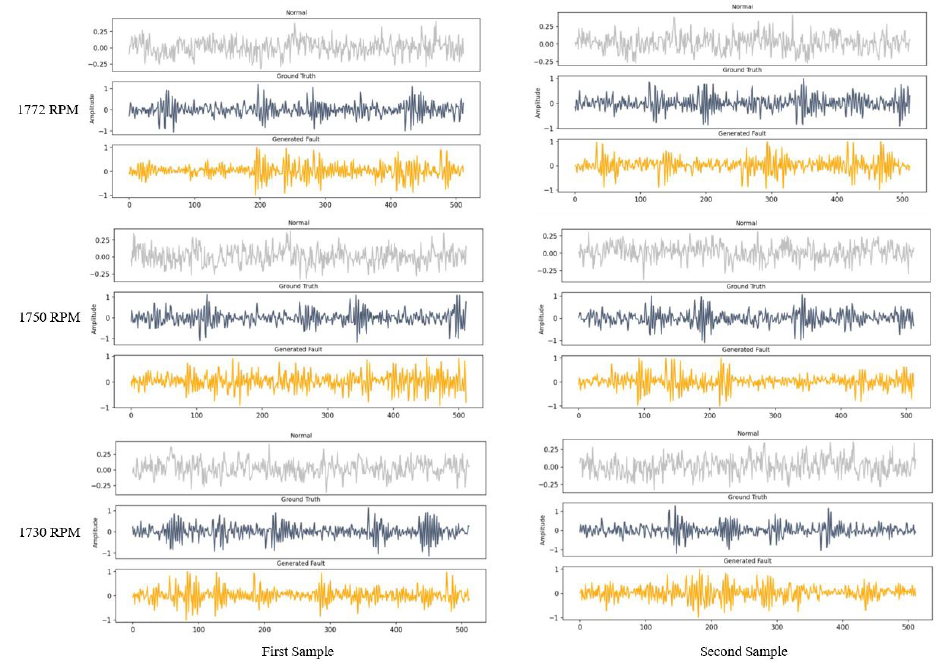
Figure 8. Some samples of the generated fault data for different